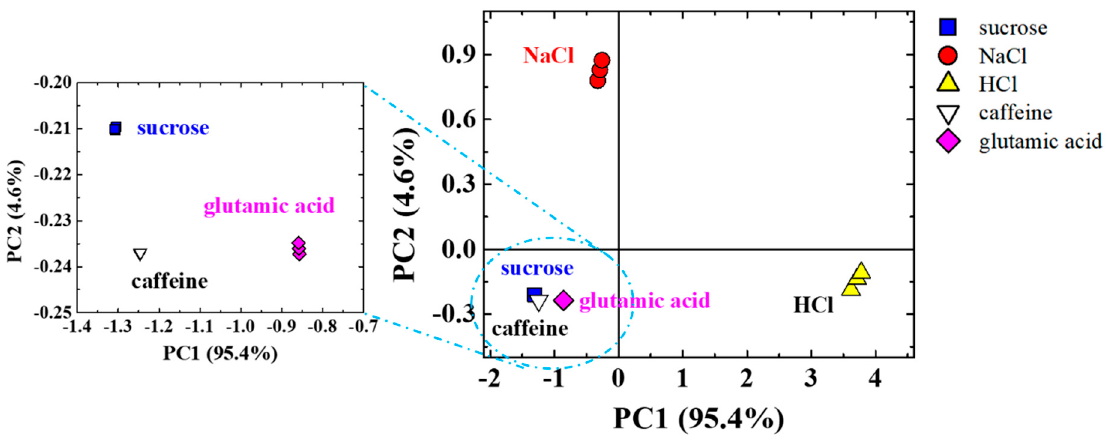
Figure 4. Principal Component Analysis (PCA) score plot of the capacitance data at 1 kHz in three independent sets of measurements obtained with the microfluidic e-tongue mixer used to evaluate basic tastes relevant to human gustative perception (sweet, salty, sour, bitter, and umami) at 1 mL / h flow.